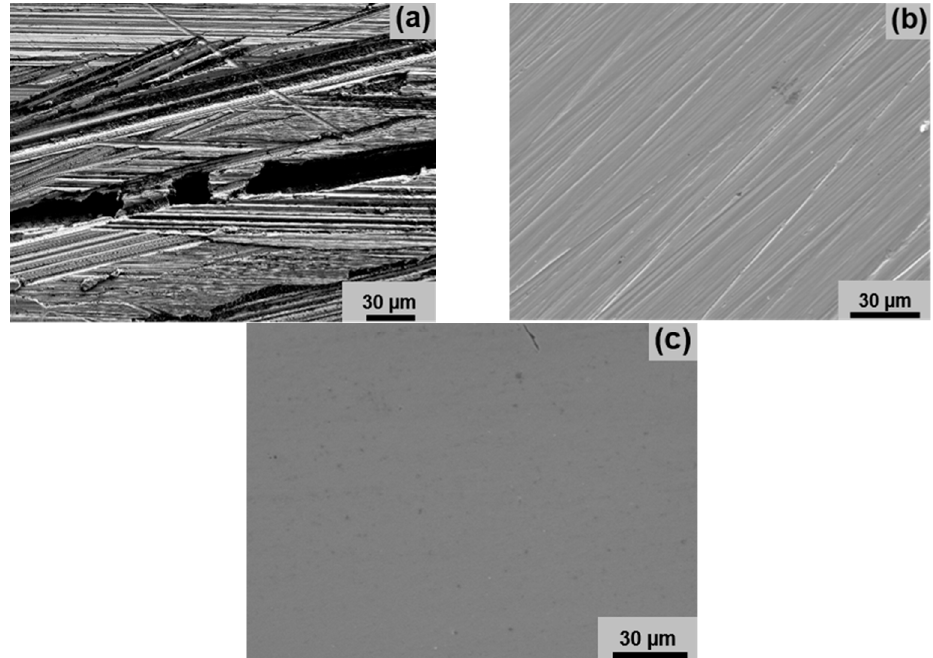
Figure 1. SEM observations of 304L SS after, ( a ) grinding process, ( b ) polished samples down to 2400 with SiC, ( c ) polished samples down to 1 µm with diamond paste.